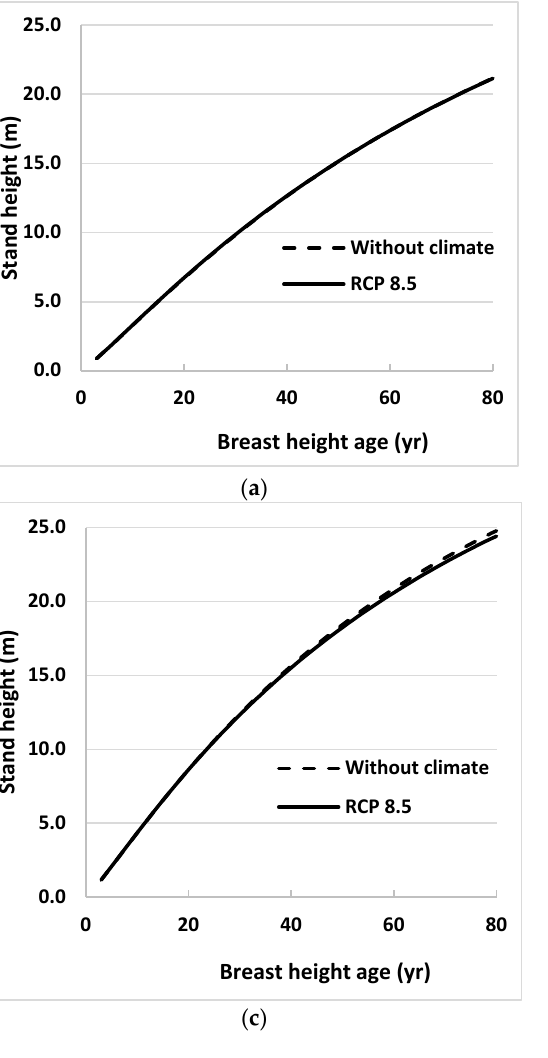
Figure 2. Stand height profiles for natural origin black spruce trees generated using projected values of climate variables for the period 2021 to 2080, assuming that climate remains stable (without climate) or warms (RCP 8.5), in Equation (3) for ( a ) eastern (near Timmins), ( b ) central (near Hearst), ( c ) western (near Thunder Bay), and ( d ) far western (near Kenora), ON, Canada. Climate variables were projected for locations close to sample sites using 3 emissions trajectories known as representative concentration pathways (RCPs).